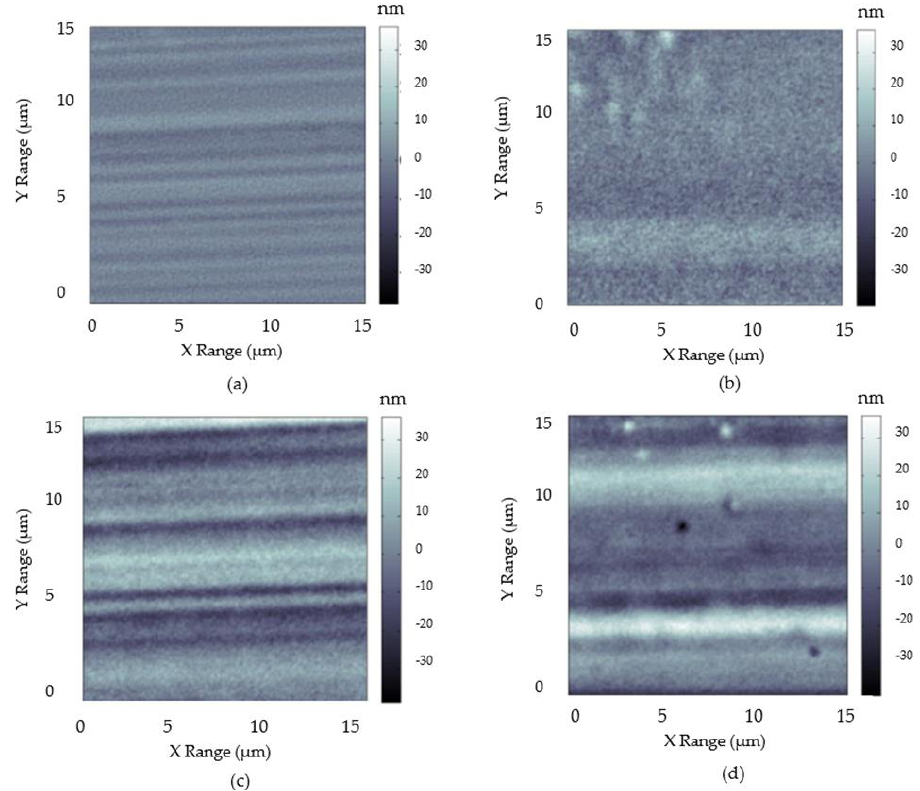
Figure 24. White light interferometer images for ( a ) germanium; ( b ) YAG; ( c ) lithium niobate; ( d ) silicon [74].